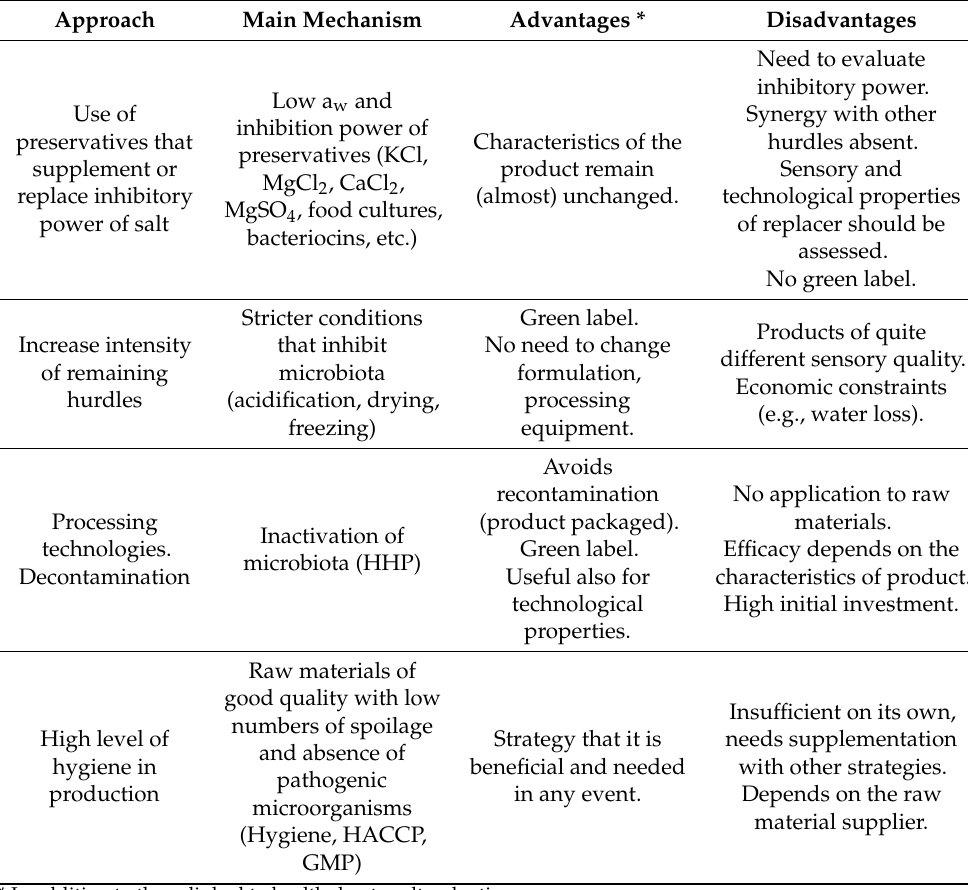
Table 4. Approaches to guarantee the microbiological safety of low-salt meat